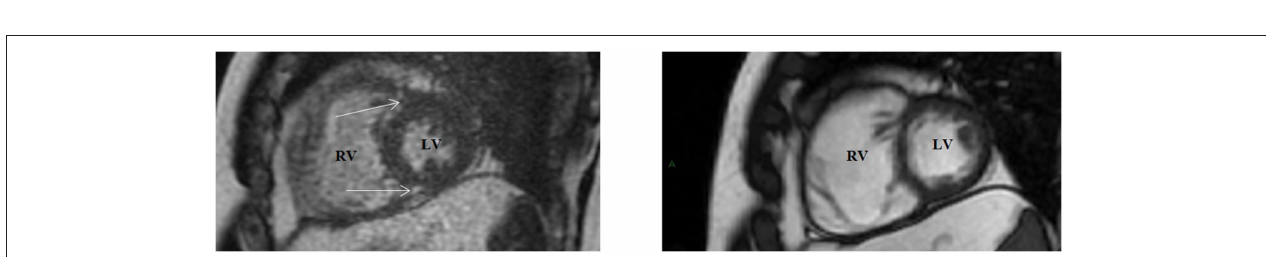
FIGURE 5 | Steady-state free precession (SSFP) cine imaging by cardiac magnetic resonance of a patient with group 3 pulmonary hypertension. SSFP in the four-chamber (4C) orientation at end-diastole (A) showing right ventricular enlargement, and at mid-systole (B) showing tricuspid regurgitation. (C) SSFP in the short-axis (SAX) orientation depicts malcoaptation of the tricuspid valve leaflets. SSFP in the two-chamber (2C) (D) and three-chamber (3C) (E) orientations in systole showing again tricuspid regurgitation. LA, left atrium; LV, left ventricle; RA, right atrium; RV, right ventricle; TR, tricuspid regurgitation; TV-A, tricuspid valve anterior leaflet; TV-P, tricuspid valve posterior leaflet; TV-S, tricuspid valve septal leaflet.